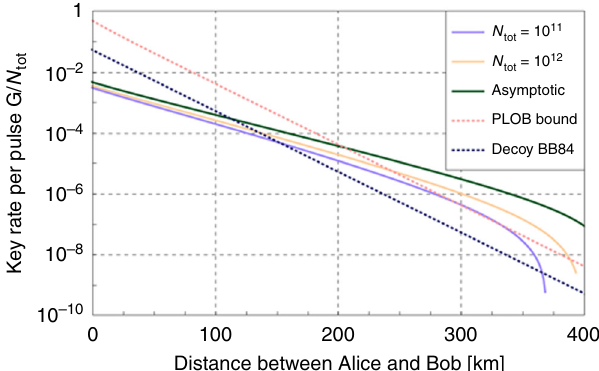
Fig. 3 The key rate per pulse as a function of distance L between Alice and Bob. We assumed a fi ber loss of 0.2dB/km, a loss-independent misalignment error of e m = 0.03, a detector dark counting probability of p d = 10 − 8 , and a detection ef fi ciency of η ¼ 0 : 3. The rate in the asymptotic limit and those in d the fi nite-size cases with transmission of N 10 11 , 10 12 pulse pairs are tot ¼ shown. For comparison, we also show the PLOB bound 4 and the asymptotic key rate of ideal decoy-BB84 protocol 2,4 for the direct link transmissivity η 10 (cid:2) 0 : 2 L = 10 d